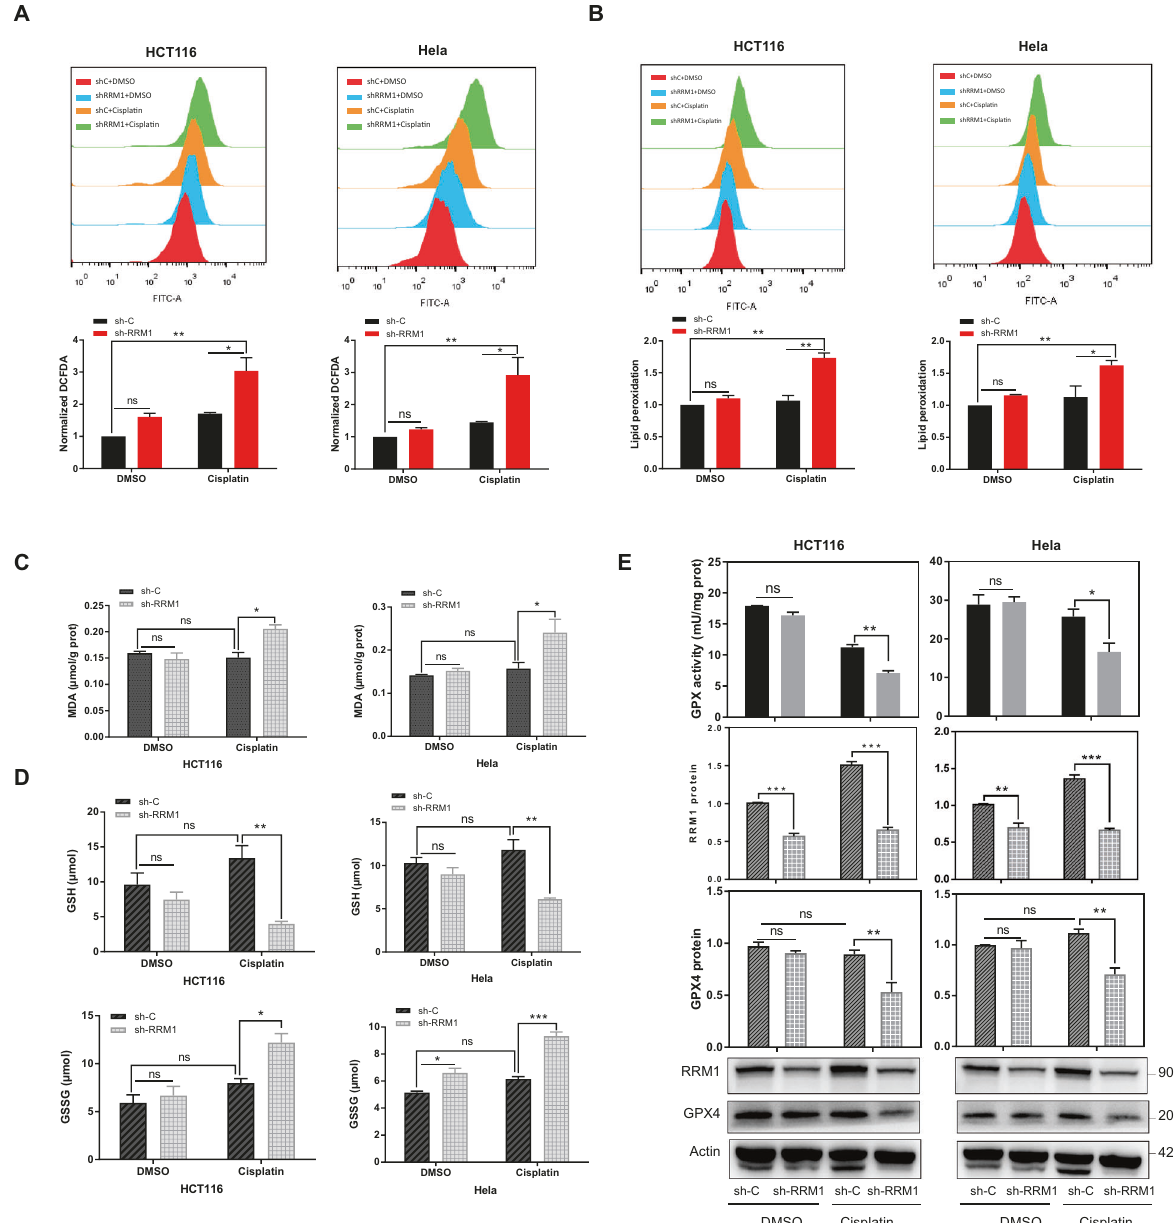
Fig. 5 RRM1 mediates chemosensitivity in cancer cells. A , B Total ROS (A) and lipid peroxidation (B) were measured in RRM1 knockdown cells at 48 h after exposure to 5 µg/mL cisplatin. C Knockdown of RRM1 increased cisplatin-induced MDA production. D The levels of GSH and GSSG were assayed in RRM1 knockdown cells after treatment with 5 µg/mL cisplatin. E Lower GPX activity and GPX4 expression were detected in RRM1 knockdown cells 48 hours after 5 µg/mL cisplatin treatment. a negative regulator of radio-/chemotherapy-induced ferroptosis. RRM1 increases the instability of p53 by regulating the physical interaction of p53 with the ubiquitinating enzyme MDM2 and the deubiquitinating enzyme USP11, subsequently suppressing p21 and GPX4, thereby promoting the accumulation of lipid peroxida- tion and occurrence of radiation-induced ferroptosis. In summary, our fi ndings offer new mechanistic insight into the regulation of RRM1 and indicate that the lack of RRM1 exacerbates ferroptosis of cancer cells upon DNA damage, and targeting RRM1 improves radio-/chemotherapy. Accumulating evidence has demonstrated that tumor cells are prone to synthesize more antioxidants to resist radiation-induced ROS [5, 6]. Our fi ndings show that radiation signi fi cantly increases Cell Death Discovery (2022)